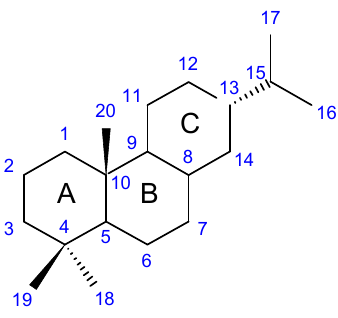
Figure 1. Hydrocarbon skeleton of abietane diterpenes [19,20].